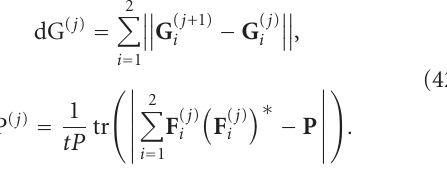
P = 15dB. ( Legend: the 4 di ff erent colors in the two middle subplots 10